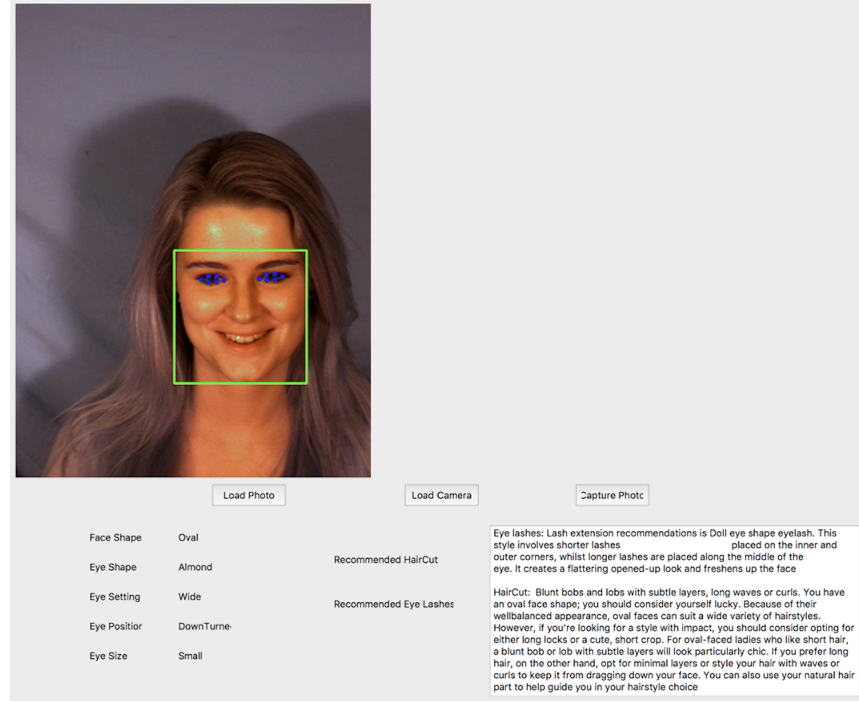
Figure 10. GUI of facial and eye attributes predication showing woman